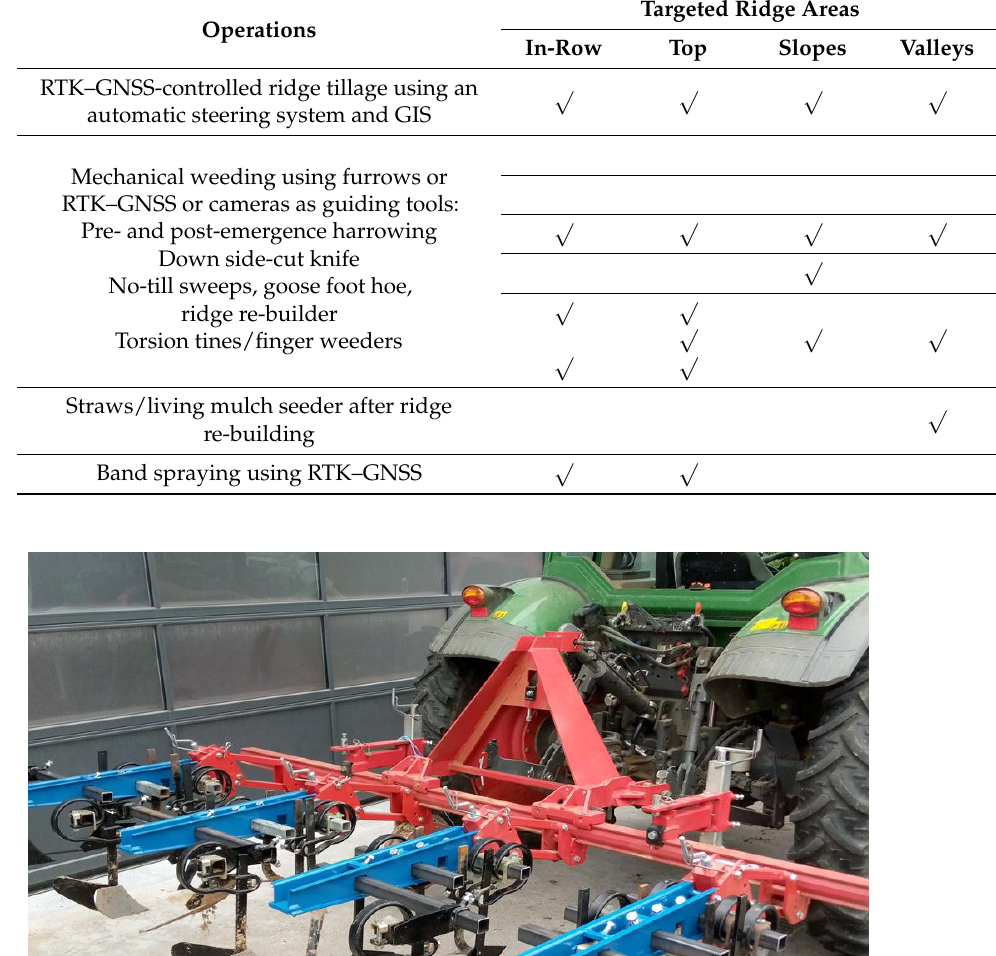
Table 1. Options for improving weed control in ridge tillage (RT) systems using precision farming technologies based on experiments with a new RT system, including re-compaction of the dams (Alagbo et al., 2022).